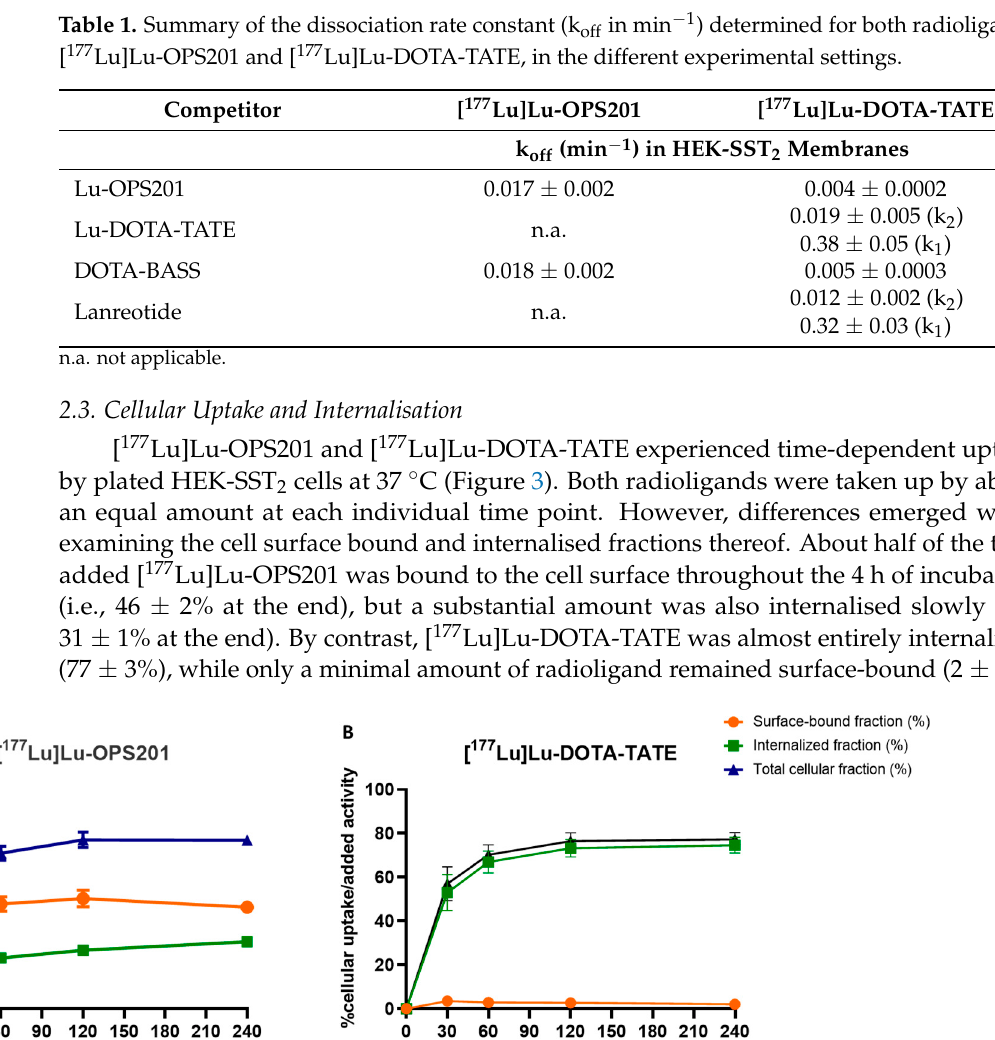
Table 1. Summary of the dissociation rate constant (k off in min − 1 ) determined for both radioligands,